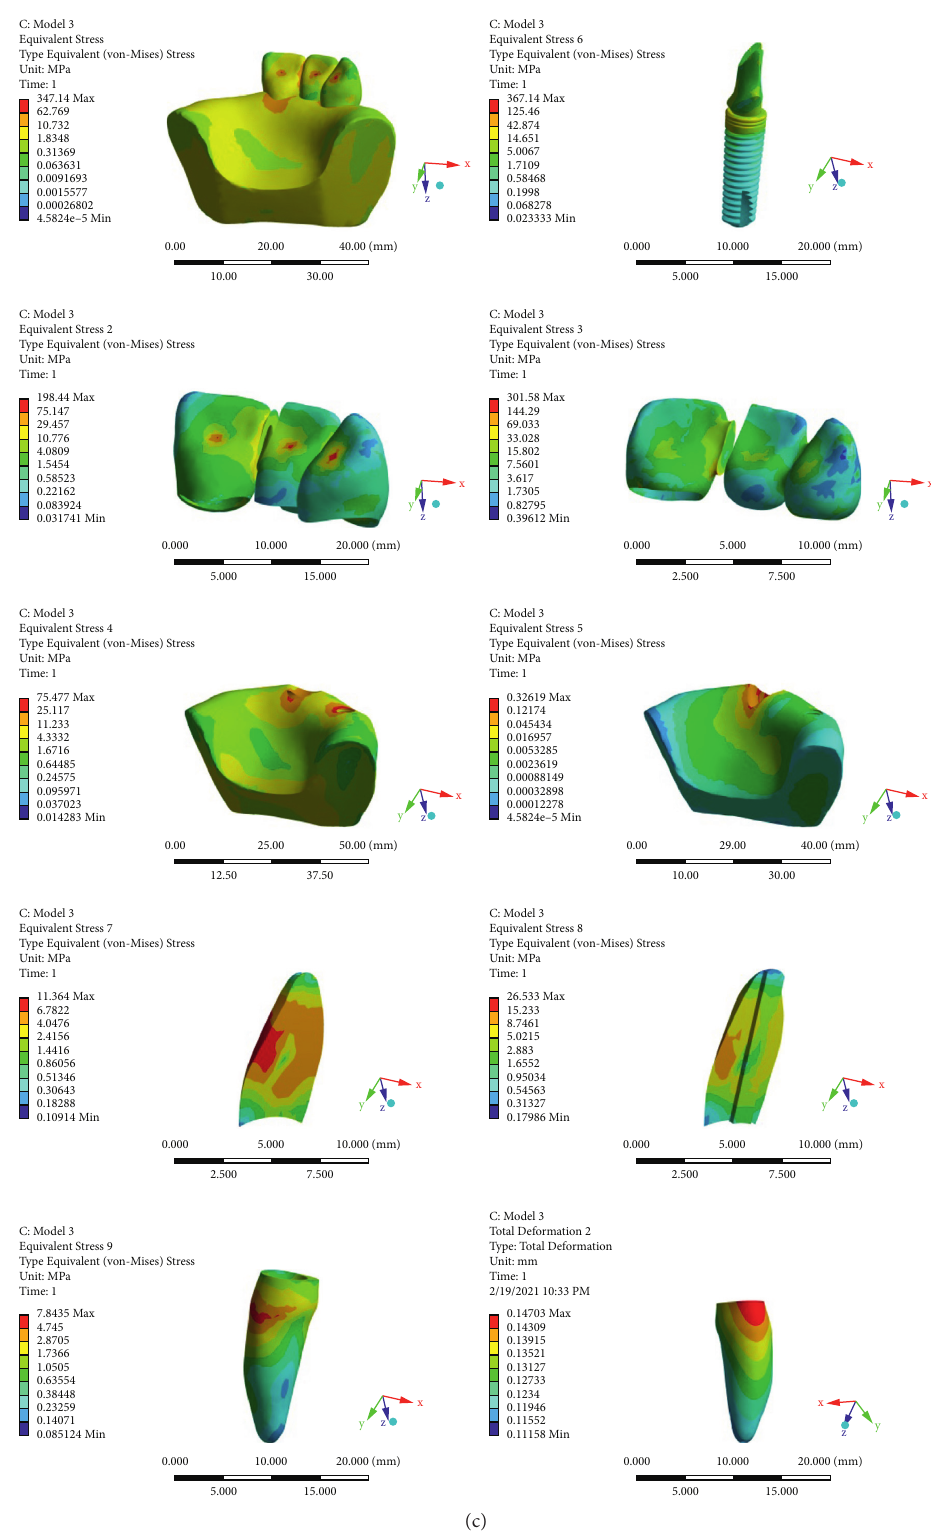
Figure 4: (a) Color spectrums depict stress distribution of the entire model, implant, porcelain, metal frame, cortical bone, spongious bone and natural tooth (MPa) and the tooth vertical displacement (mm) under oblique loading in the first model. (b) Color spectrums depict stress distribution of the entire model, implant, porcelain, metal frame, cortical bone, spongious bone, patrix, matrix and natural tooth (MPa) and the tooth vertical displacement (mm) under oblique loading in the second model. (c) Color spectrums manifest stress dis- tribution of the entire model, implant, porcelain, metal frame, cortical bone, spongious bone, matrix, patrix and natural tooth (MPa) and the tooth vertical displacement (mm) under oblique loading in the third